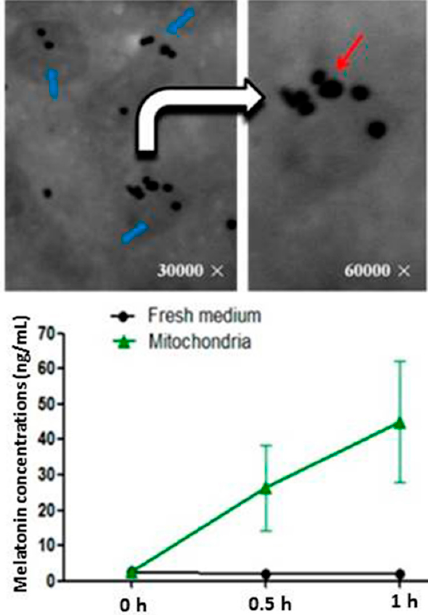
Figure 2. Upper panel: The localization of the SNAT. Blue arrows: The mitochondria isolated from the oocytes of mice. White arrow: enlarged image from left side of the arrow tail. Red arrow: SNAT staining (black dot). SNAT: serotonin N -acetyltransferase; Low panel: Melatonin concentrations in mitochondrial culture media with 10 − 4 M serotonin (mean ± SEM) modified from He et al. [112].